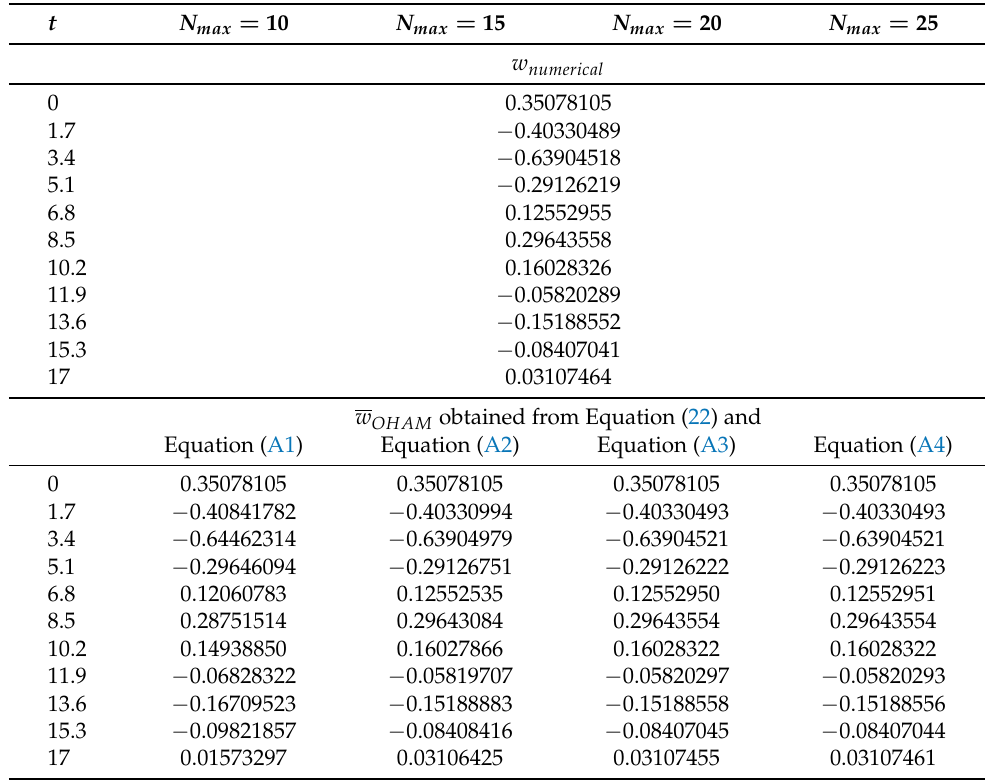
Table 1. Comparison between the analytical approximate solution w OHAM of Equation (22) and the corresponding numerical values for different values of the index number N max